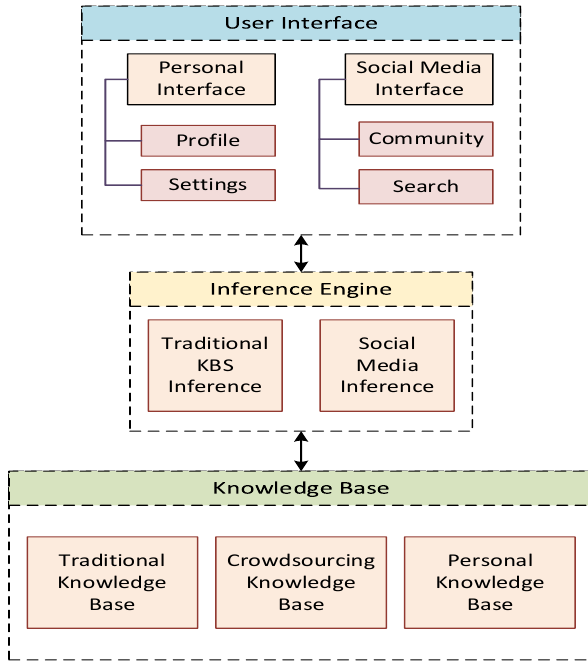
Figure 1: Conceptual Model for the Expert Agricultural Management